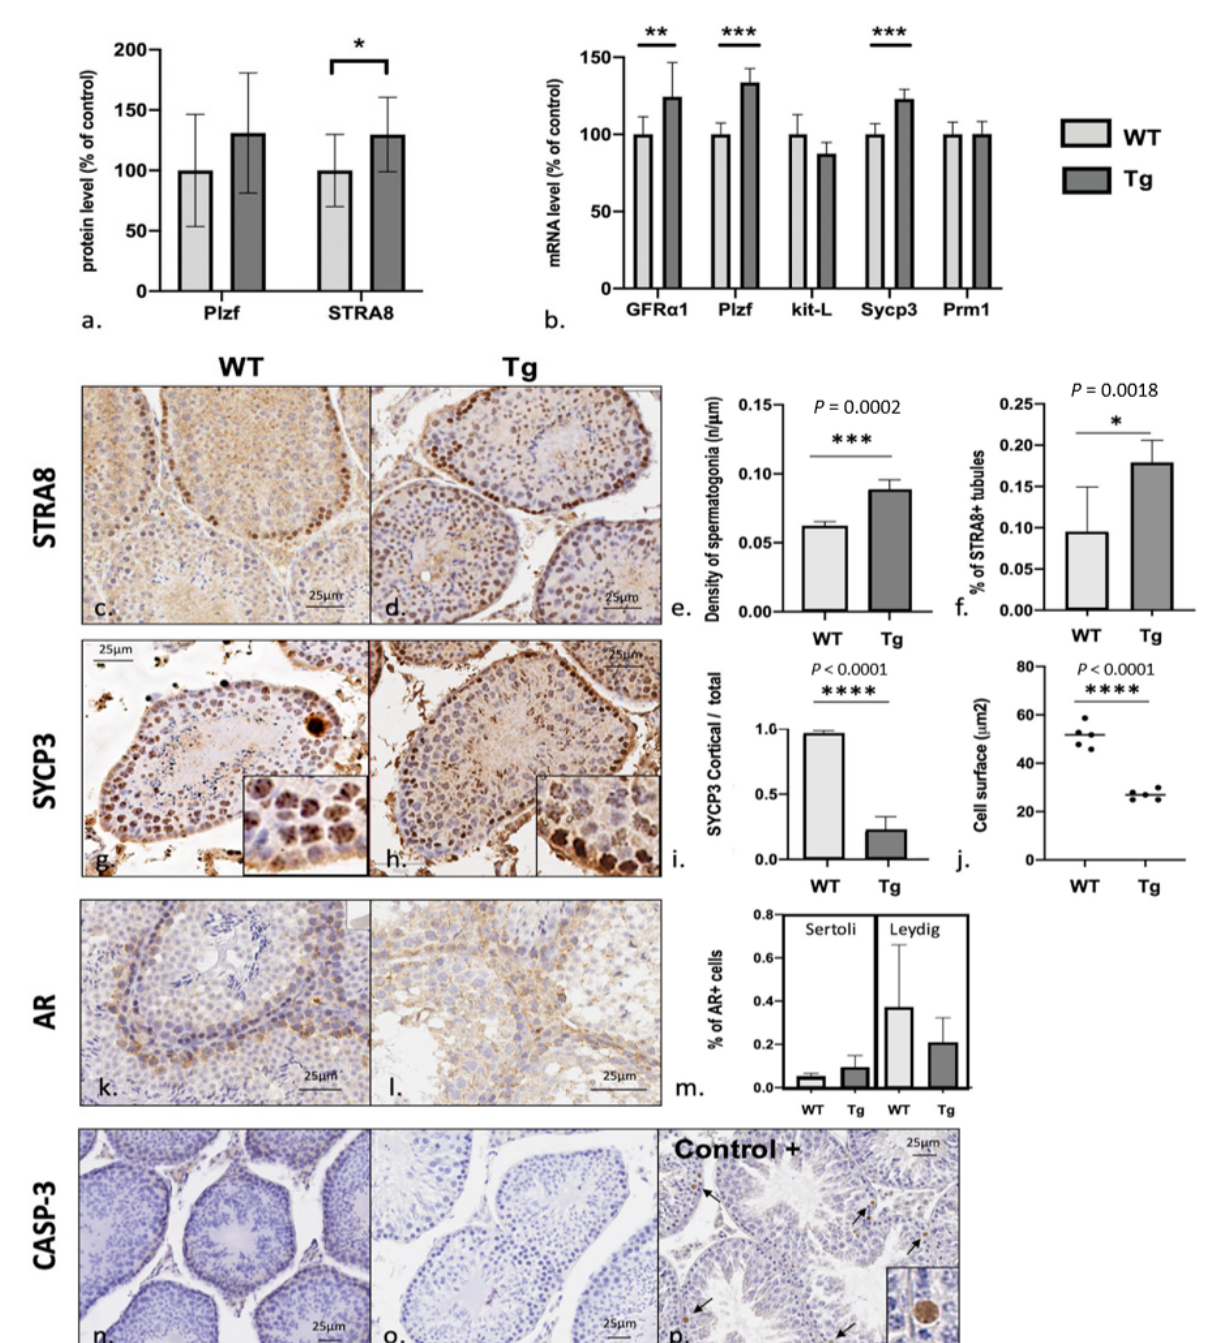
Figure 3. Spermatogenesis. ( a , b ): protein and mRNA levels of specific proteins involved in spermatogenesis from spermatogo- nial stem cells (GFRa1), spermatogonia A (Plzf and kit-L), spermatogonia B (STRA8), primary spermatocytes (SYCP3), and spermatids (Prm1). ( c – p ) IHC assay of testis in Tg mice and WT controls for STRA8, SYCP3, androgen receptor (AR), and caspase 3 (CASP3, an apoptosis marker). STRA8 immunostaining revealed an elevated quantity of spermatogonia B in Tg mice, in terms of the number of positive cells per tubule and the number of positive tubules in the whole section. In Tg mice, SYCP3 staining revealed aberrant expression in cells with the same morphology as spermatogonia, i.e., small cells close to the basal membrane. In WT mice, the stained cells corresponded to primary spermatocytes, as expected. There was no intergroup difference in AR staining. There was no difference in cleaved caspase-3 staining between Tg and WT mice; no apoptosis was observed in either group, relative to a heat-induced positive control (arrows). p value : 0.033 (*), 0.002 (**), <0.001